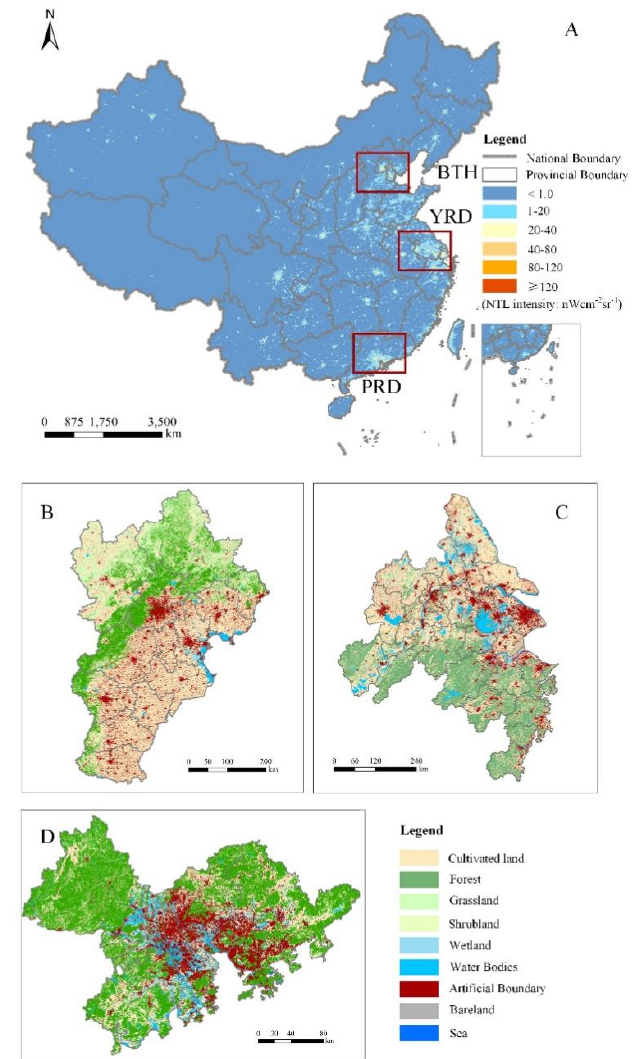
Figure 1. Locations and land cover distribution of the three urban agglomerations (( B ): Yangtze River Delta [YRD], ( C ): Beijing–Tianjin–Hebei [BTH], ( D ): Pearl River Delta [PRD]) in China and a nighttime light (NTL) image of China in 2020. ( A ): NTL image of China in 2020. ( B – D ): Locations of YRD, BTH, and PRD. Note: Considering that Zhoushan City is composed of many small islands and is adjacent to the sea, the connection between the regional thermal environment is weak; therefore, it was excluded from the study area of the YRD urban agglomeration.